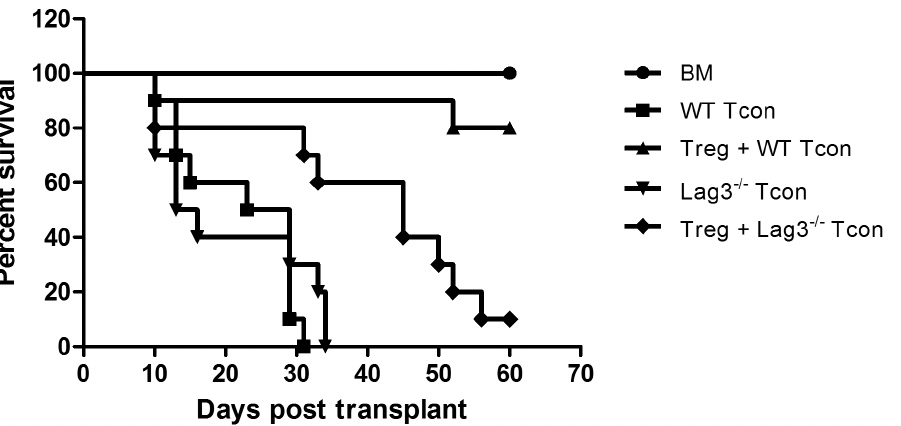
Figure 3. Regulatory T cells are less able to control Lag-3 2 / 2 Tcon. Lethally irradiated Balb/c recipients were transplanted with 5 6 10 6 TCD- BM and 5 6 10 5 WT Treg on day 0 followed by infusion of 1 6 10 6 Lag-3 2 / 2 or WT Tcon on day 2. WT Treg provided less protection against GVHD induced by Lag-3 2 / 2 Tcon as compared to WT Tcon. (n=10, Data in graph are pooled from two independent transplants; P , 0.001 for Treg + WT Tcon vs. WT Tcon, P=0.03 for Treg + Lag-3 2 / 2 Tcon vs. Lag-3 2 / 2 Tcon and P=0.003 for Treg + WT Tcon vs. Treg + Lag-3 2 / 2